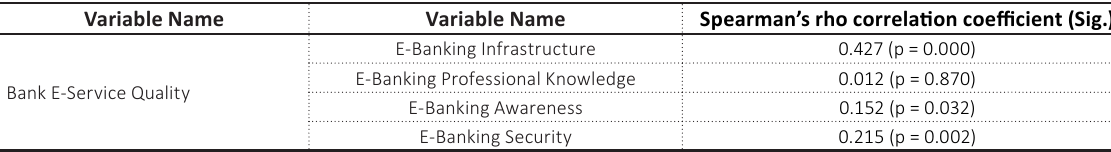
Table 2. Spearman’s rho correlation coefficient